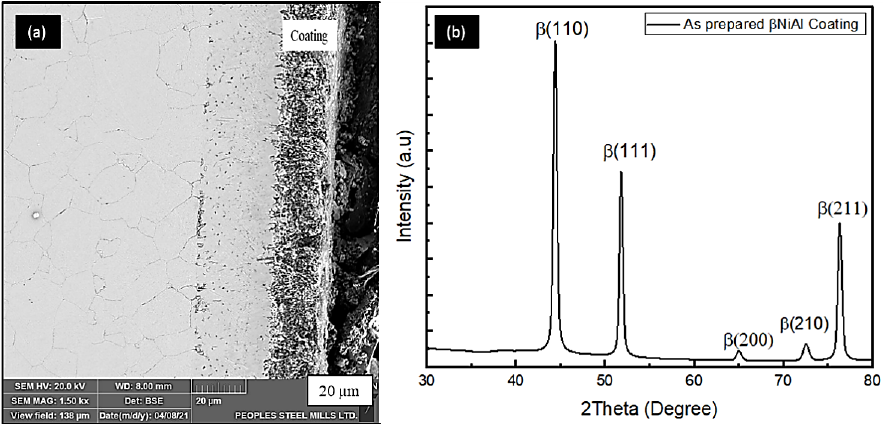
Figure 6. The XRD spectrum of the coating formed after aluminizing ( a ) as deposited on the substrate, ( b ) XRD analysis for the same. Typical peaks could be seen in the spectrum. Thus, this translates that the successful coating procedures were adopted.